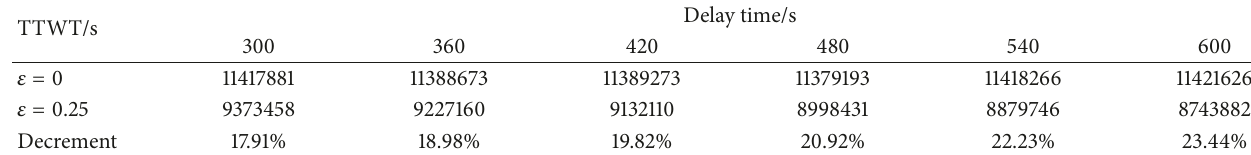
Figure 4: Numerical results with changing 𝜀 and the approximate Pareto frontier. Table 4: Solution results of Scenario 1 with different delay times.